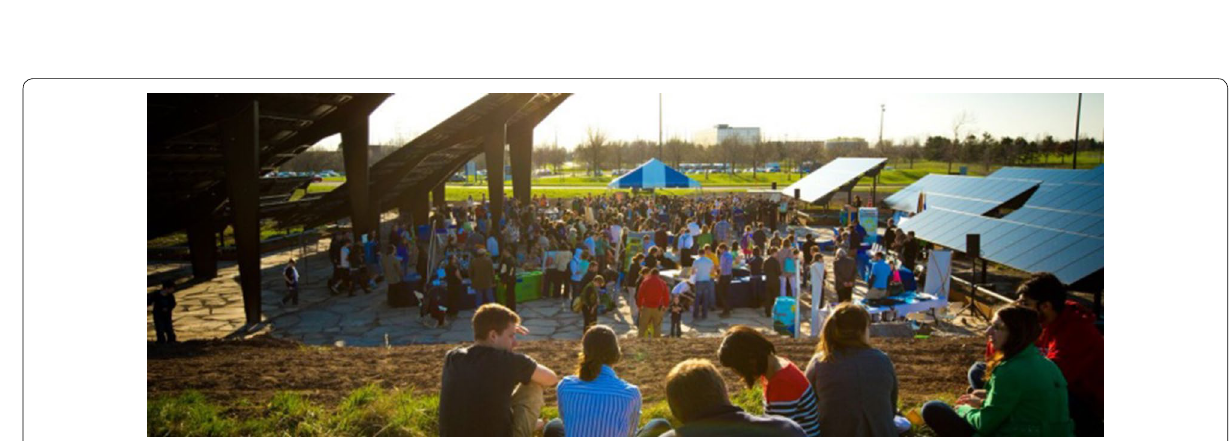
Fig. 14 Buffalo Solar Strand: photovoltaic park with classrooms and outdoor paths (from http://www.buffa lo.edu)